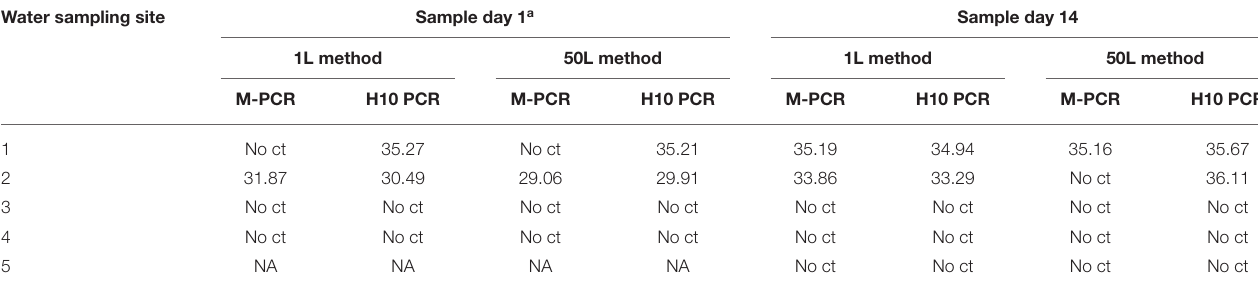
TABLE 1 | Detection of AIV by the M-PCR and H10-specific rRT-PCR in water samples using the 1L and 50L water sample method. Water sampling